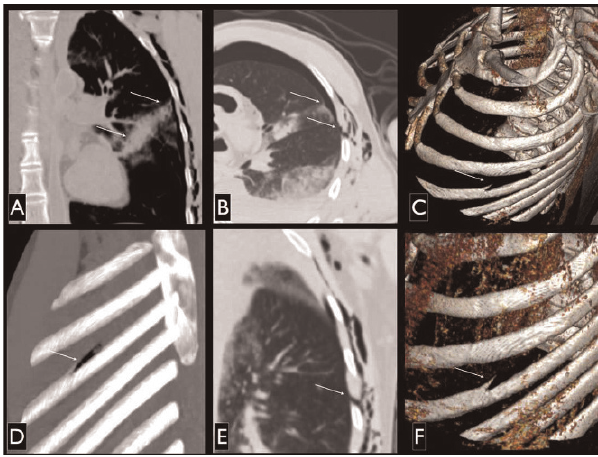
Figure 3 - PMCT images, multiplanar reconstruction coronal (A), coronal minimum intensity projection (B) and axial (C) pulmon- ary window; three-dimensional reconstruction technique for maximum intensity projection (D) and volume rendering show- ing bony structures in the left oblique lateral view. Note the lesion wound in the skin and the lung injury (A and B), the details of the lesion in the fifth left rib (in C, D and F) and the distance between the lateral aspect of the path of lung injuries and skin lesions and rib while the arm is positioned down (detail B).